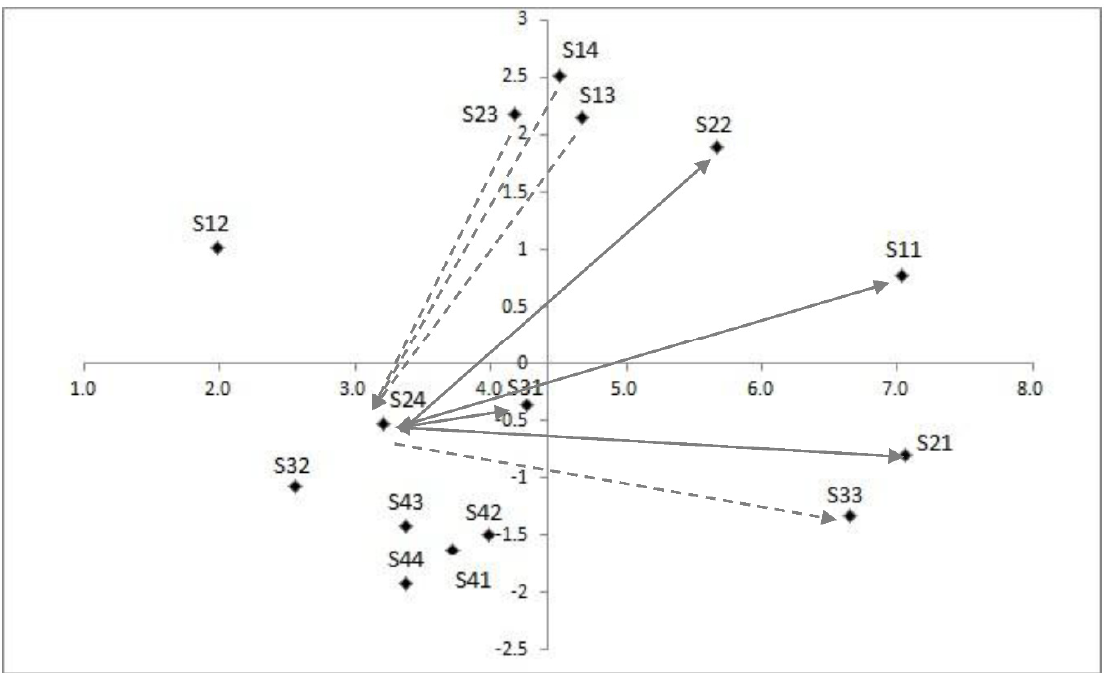
Figure A8. Casual Diagram between S24 and Other